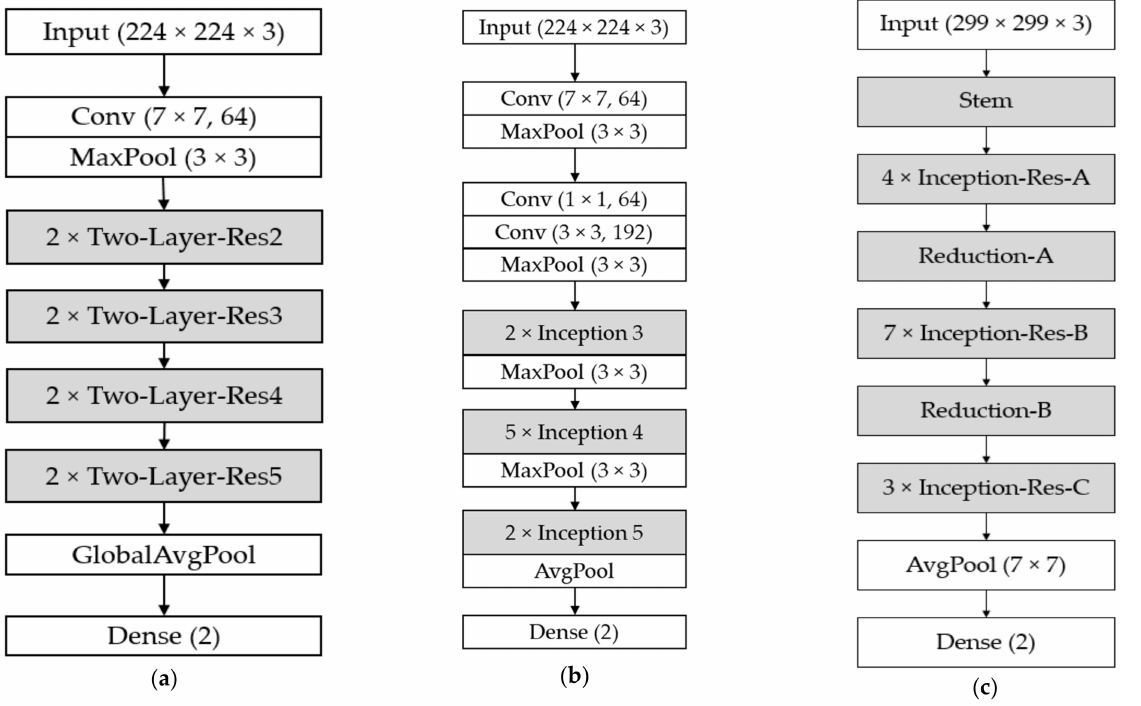
Figure 4. Structures of the CNNs used in our method: ( a ) ResNet-18, ( b ) GoogleNet, and ( c ) Inception- ResNet-v2. “Conv” denotes the two-dimensional convolutional layer, with filter size and the number of filters in parentheses; “MaxPool” and “AvgPool” indicate the max pooling and average pooling layers,